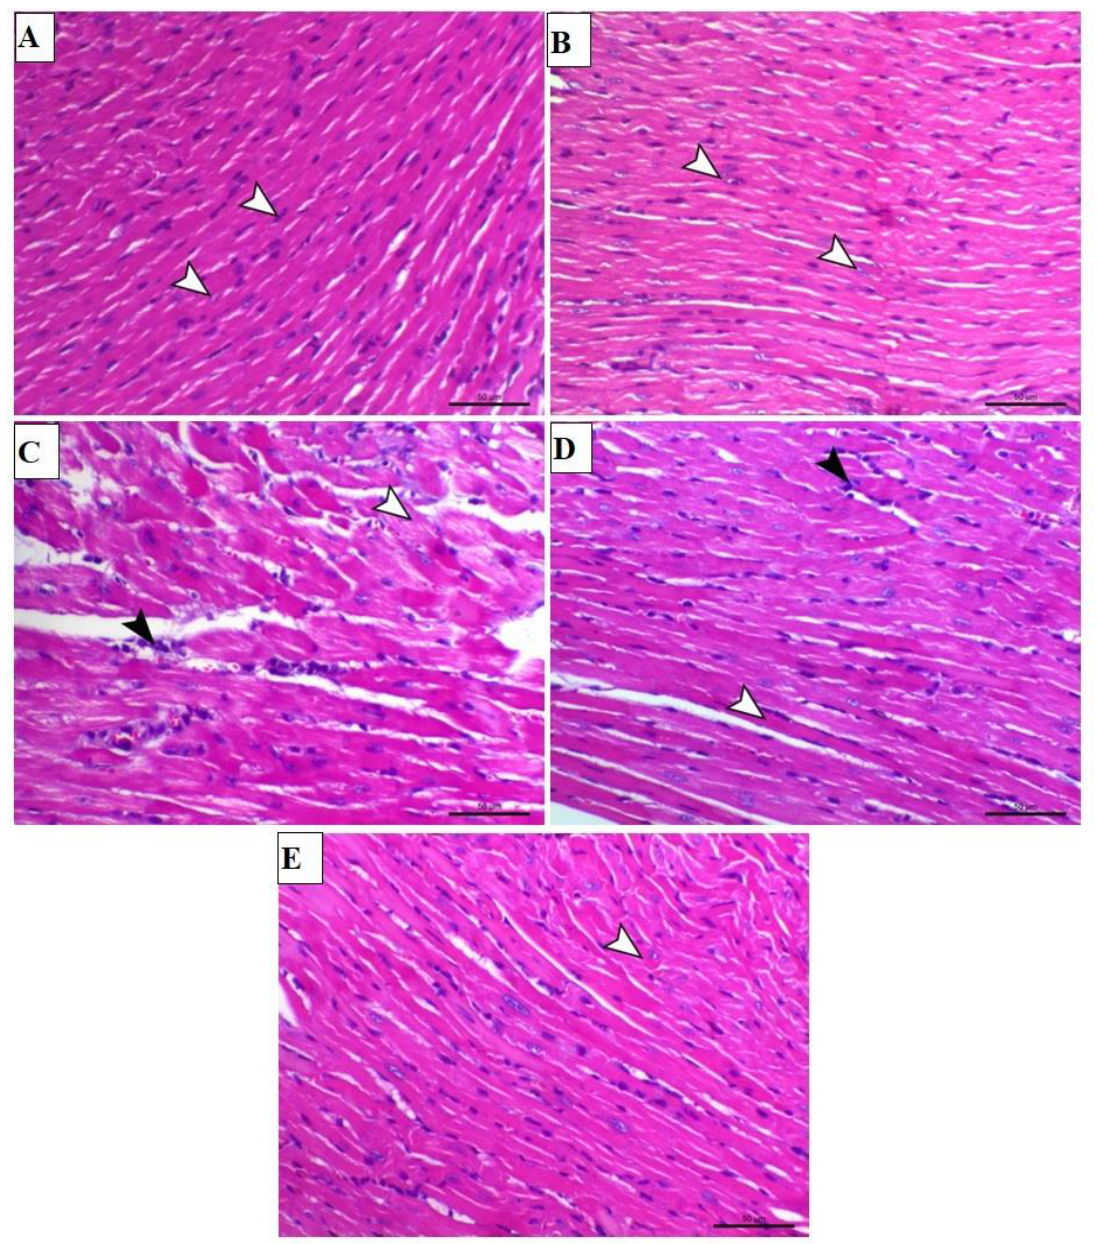
Figure 3. TAX prevents the ISO-induced histopathological damage in the heart. Images of the microscopic field of cardiac sections from ( A ) control and ( B ) TAX-treated mice showing normal branched connected myocardial fibers with a normal central nucleus (arrowheads); ( C ) ISO-treated animals demonstrating marked myolysis (white arrowhead), marked nuclear pyknosis, and infiltration of mononuclear inflammatory cells (black arrowhead); ( D ) ISO-injected mice pre-treated with 25 mg TAX demonstrating a reduction in myocardial degeneration of muscle fibers (white arrowhead) and mild infiltration of mononuclear inflammatory cells (black arrowhead); and ( E ) ISO-injected mice pre-treated with 50 mg TAX demonstrating a noticeable reduction in myocardial degeneration and with mild curving of cardiac muscle fibers (arrowhead) (H&E, X200, Scale bar = 50 µm).